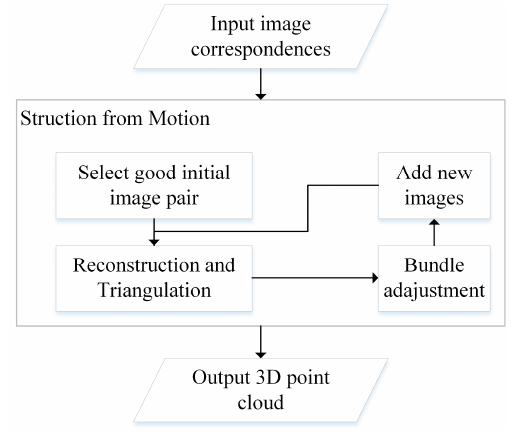
Figure 3. The process of SfM The 3D point cloud data at this time were in model coordinates without an absolute scale. Therefore, we used a laser rangefinder to establish a coordinate system with respect to the laser emission centre as the origin, so as to convert the model coordinates to the world coordinates. Finally, the origin of world coordinates was shifted to the geometrical centre of the point cloud data through coordinate transformation.